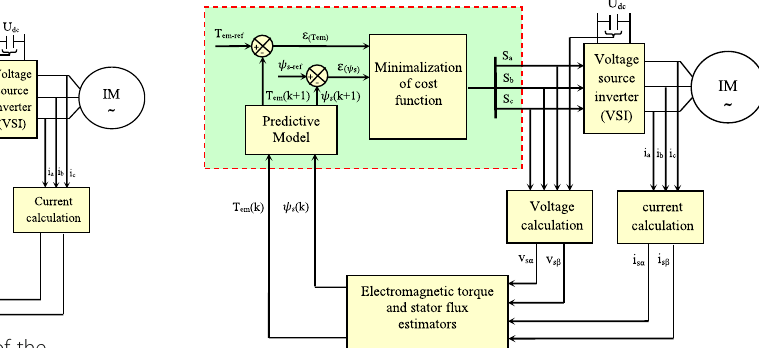
Fig. 3 Synoptic schema of DTC-SMC control of the induction machine Fig. 4 Block diagram of the